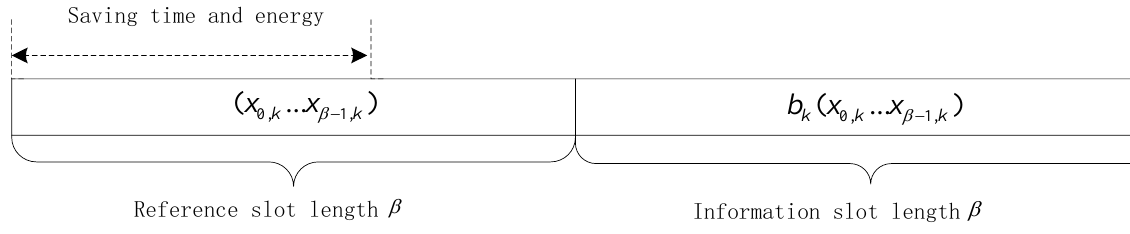
Figure 1. Frame structure of the SR-ODBR-DCSK system.